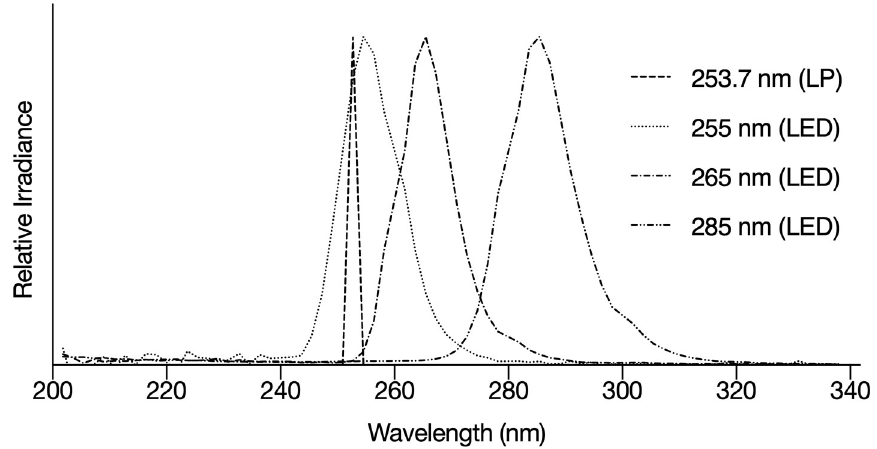
Fig 1. Emission spectra of the UV LEDs and LP